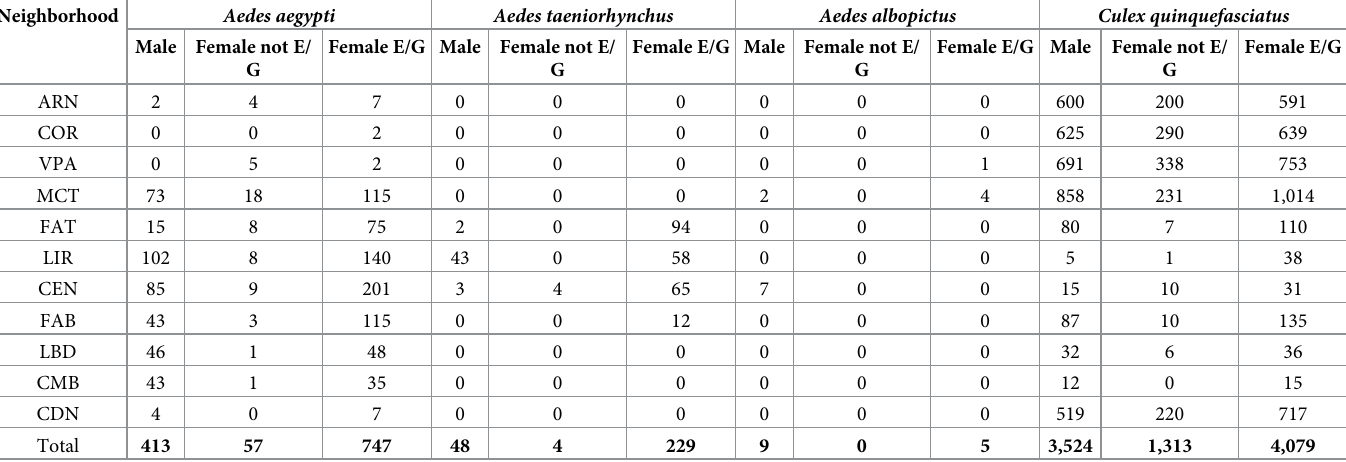
Legend: E, engorged (abdomen distended due to blood meal); G, gravid; ARN, Areinha; COR, Core´ia; VPA, Vila Passos; MCT, Monte Castelo; FAT, Fa´tima; LIR, Lira; CEN, Centro; FAB, Fabril; LBD, Liberdade; CMB, Camboa; CDN, Coroadinho. Two regions (Belira and Floresta) are officially a part of other neighborhoods (Centro and Camboa,